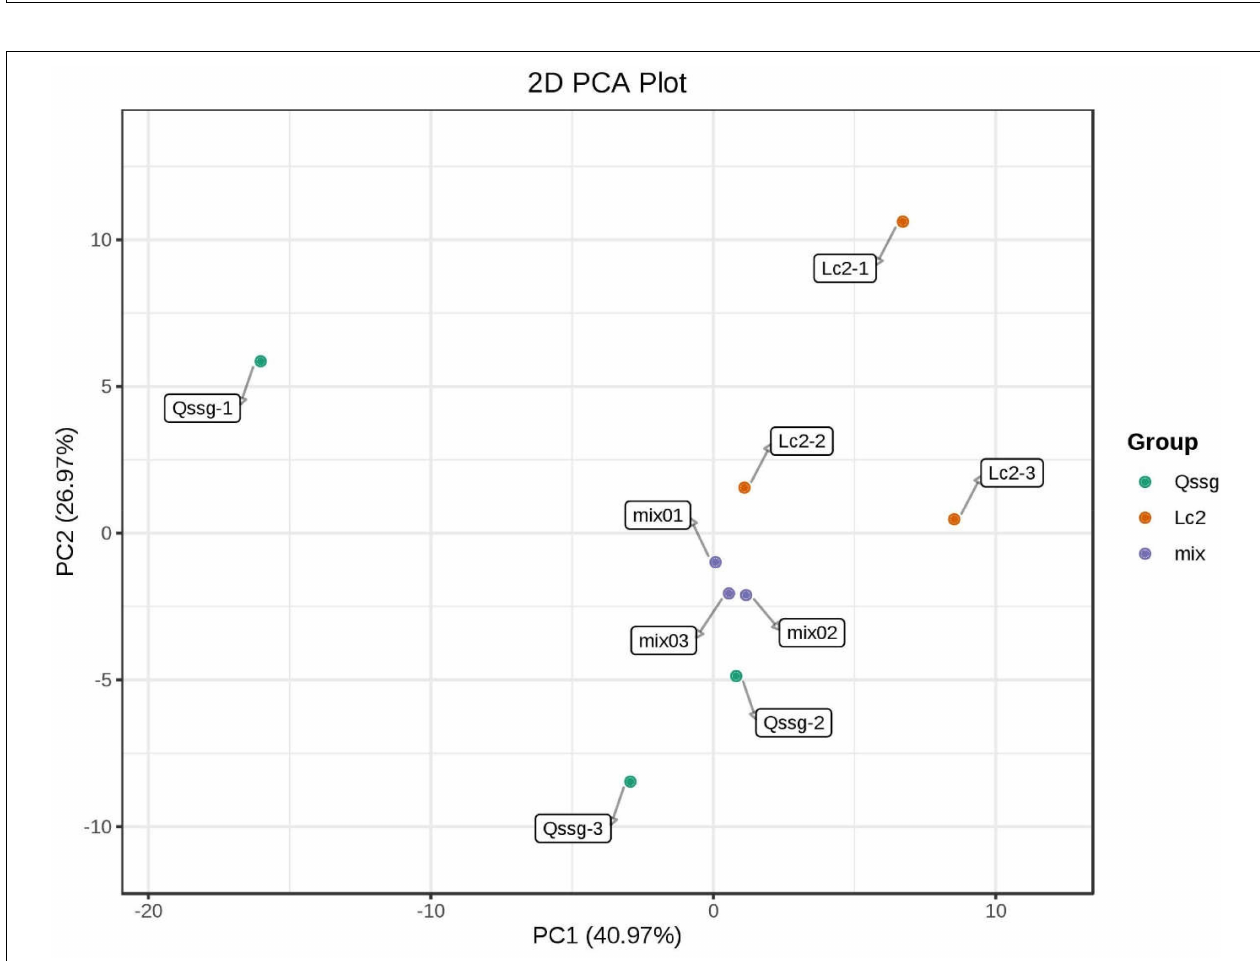
FIGURE 2 | Principal component analysis score map of metabolites in Qssg and Lc fruits. Each point represents an independent biological repeat.